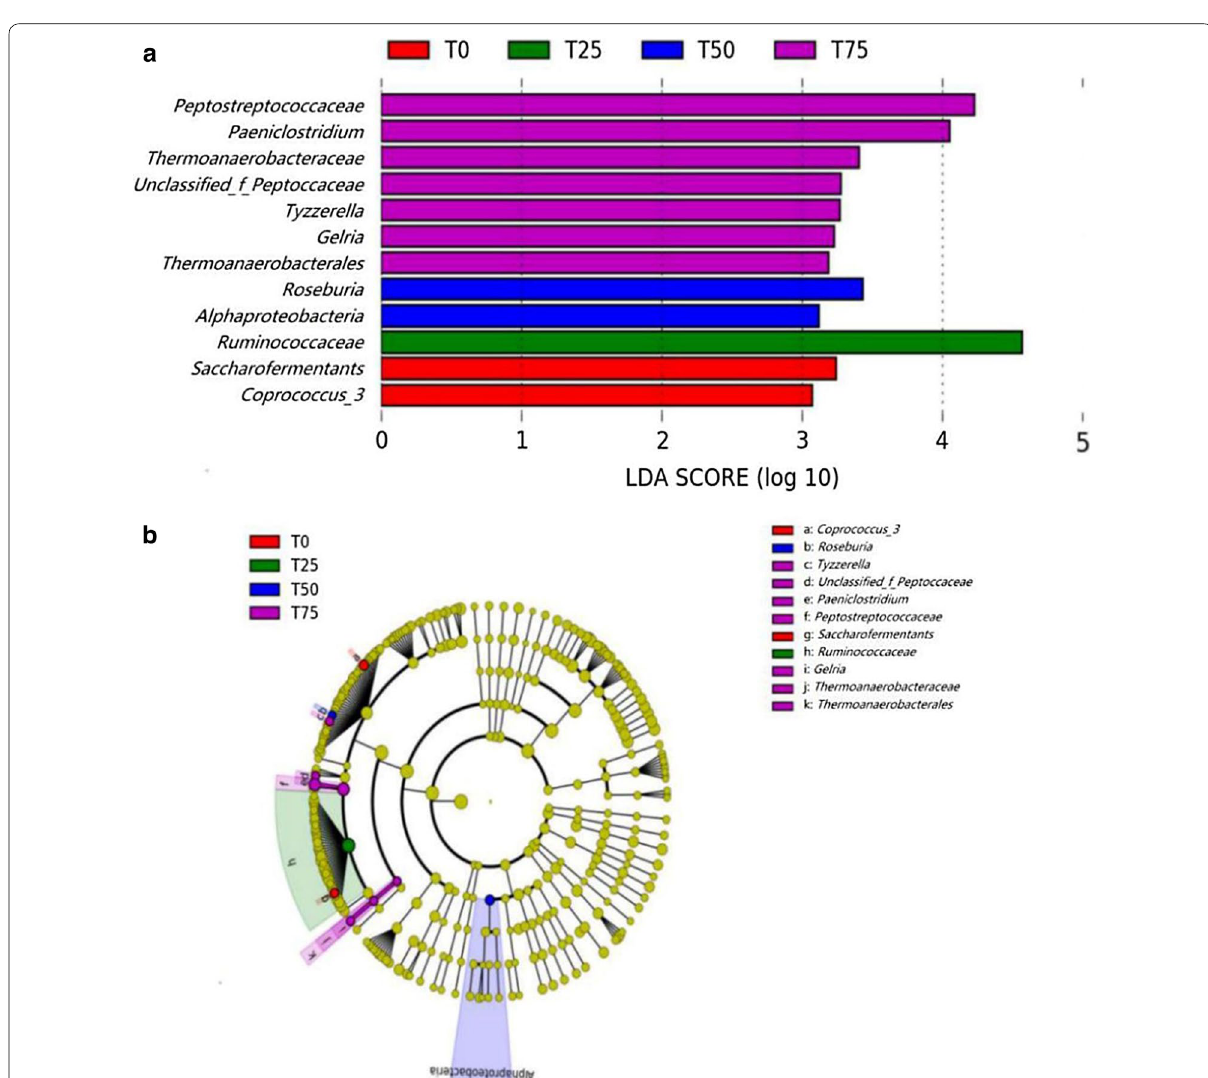
Fig. 7 Comparison of microbial variations using the LEfSe online tool. T0: BPS replaces 0% of WCS; T25: BPS replaces 25% of WCS; T50: BPS replaces 50% of WCS; T75: BPS replaces 75% of WCS. Numbers 1, 2, 3 and 4 in names of samples refer to individual heifers per set of treatment. BPS, Broussonetia papyrifera silage; WCS, whole corn silage